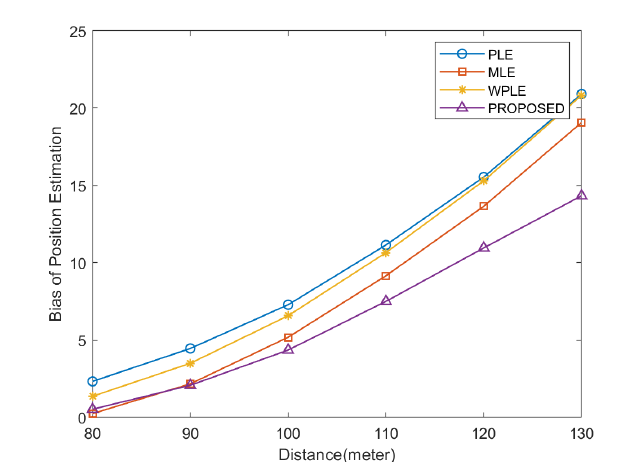
Figure 14. Bias of position estimation versus target